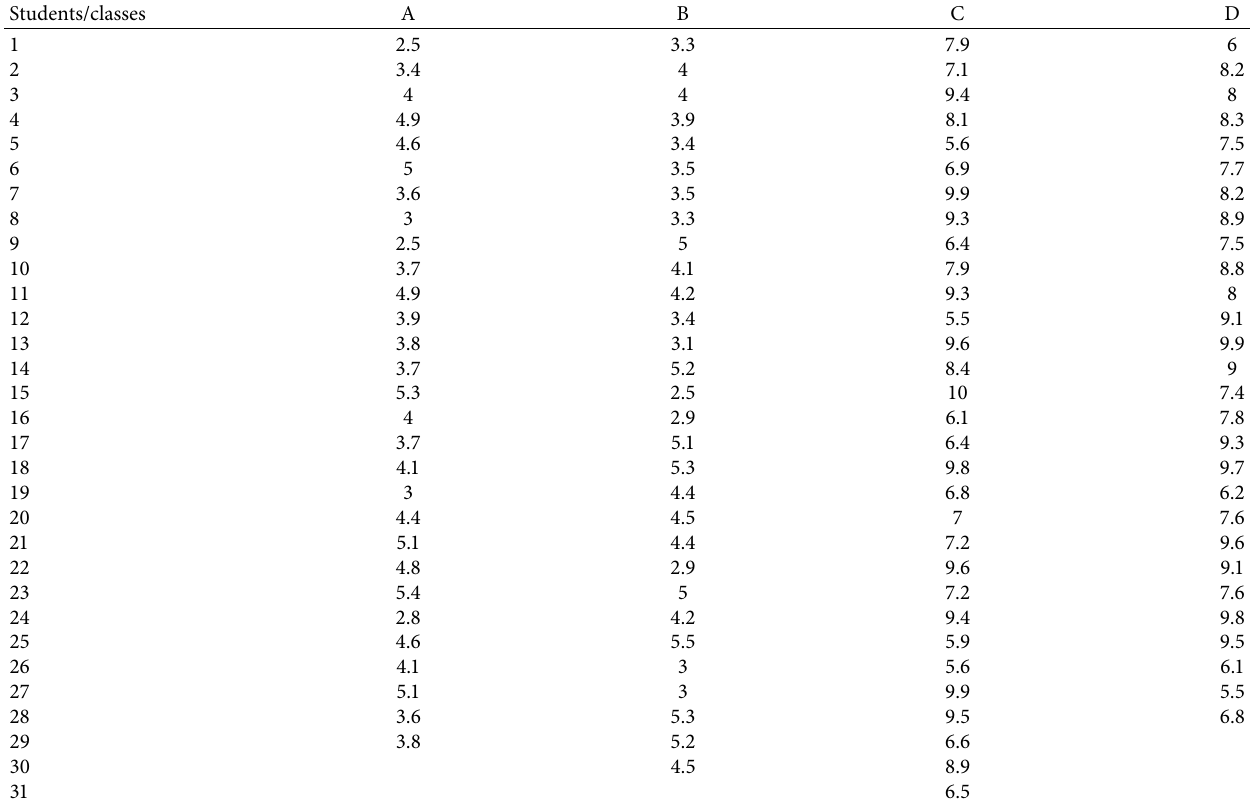
Table 4: Score statistics of four